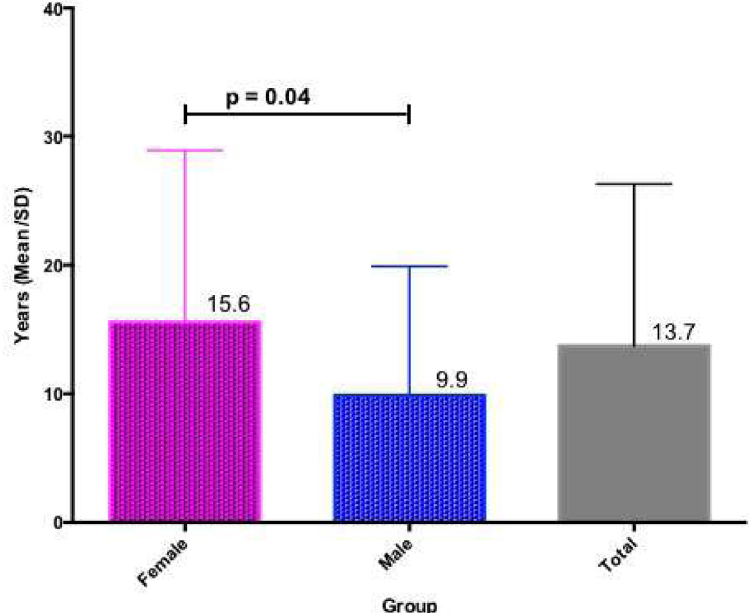
Fig. 1. Delay in hereditary angioedema diagnosis. Time in years from the fi rst manifestation to the diagnosis.